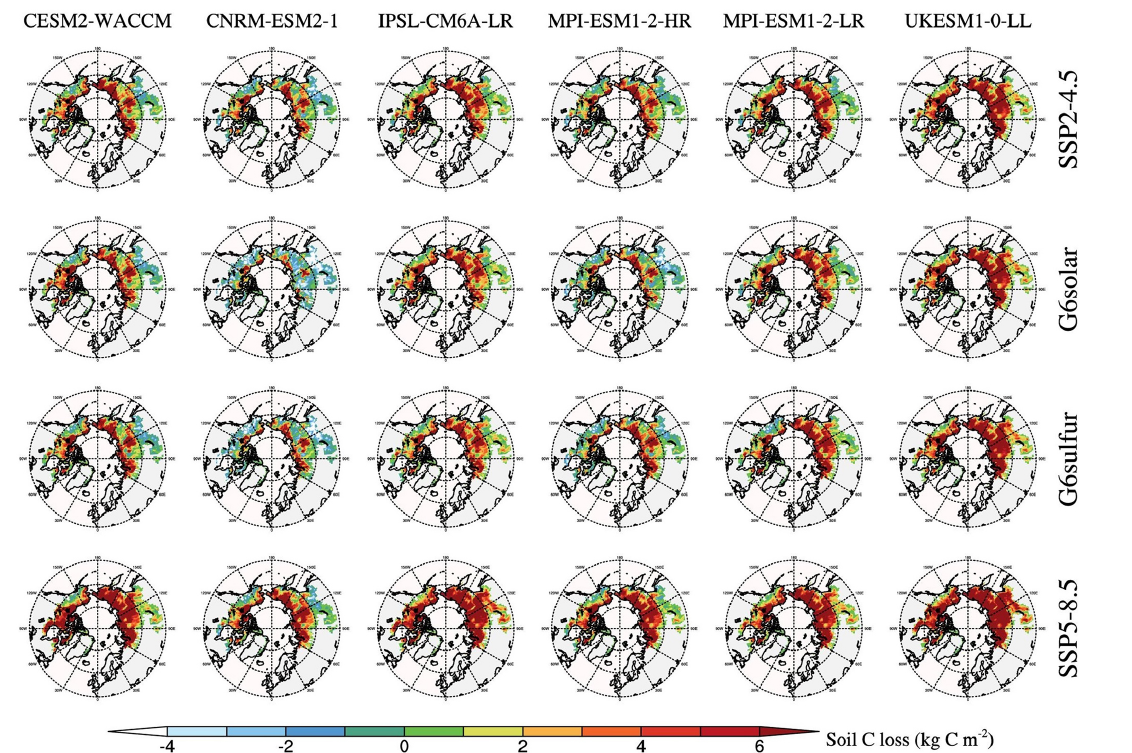
Figure 7. Maps of permafrost soil C losses between 2020 and 2100 integrated from the surface to 3m depth, obtained from modified PInc-PanTher driven by TSL, NPP, and RPE simulations.